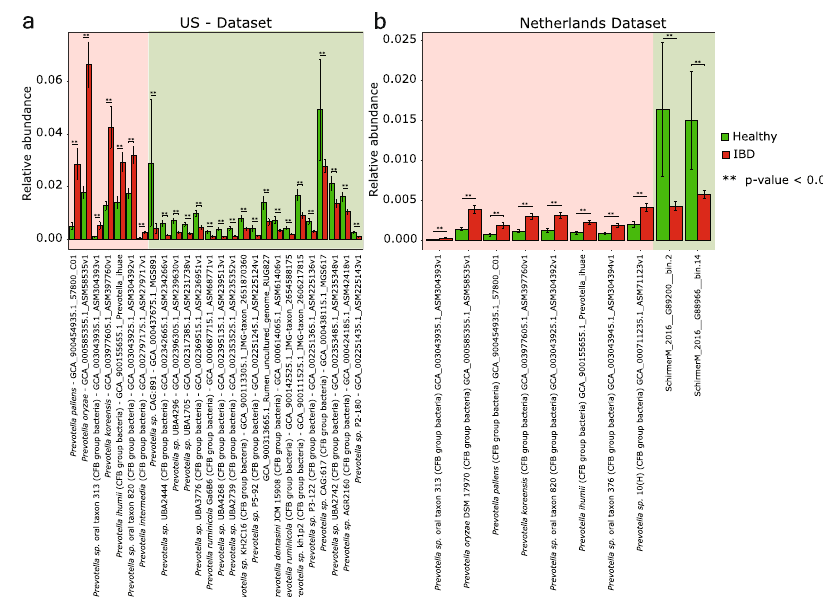
Fig. 4 Abundance of oral in fl ammation-associated Prevotella species/strains in IBD cohorts. a Representation of differentially abundant Prevotella genomes in healthy and IBD cohorts of US population. Genomes highlighted in a lighter shade of red color are differentially abundant in the IBD cohort, and genomes highlighted in a lighter shade of green color are differentially abundant in the healthy cohort. b Representation of differentially abundant Prevotella genomes in healthy and IBD cohorts of Netherlands population. Genome highlighted in a lighter shade of red color are differentially abundant in IBD cohort, and genomes highlighted in a lighter shade of green color are differentially abundant in the healthy cohort. Prevotella genomes/bins with “ indval ” score >0.60 and p -value < 0.01 reported by labdsv are represented in the bar-plots. Error bars represent plus or minus one standard error of the